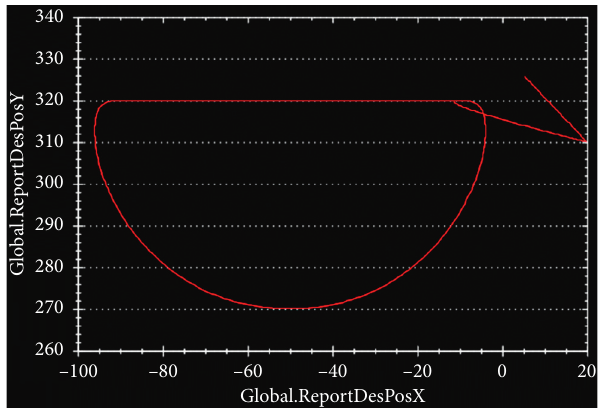
Figure 23: Movement trajectory of the foot (mm).